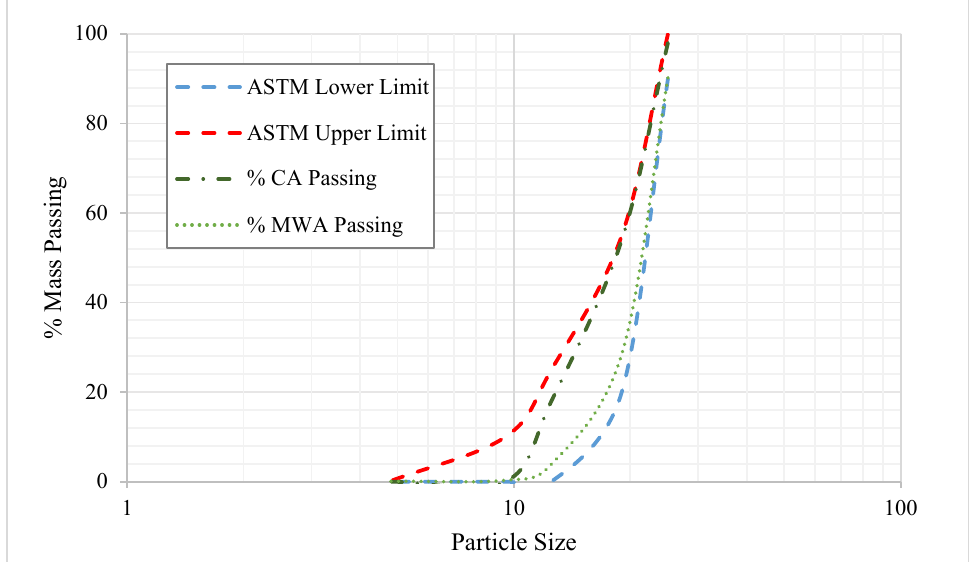
Figure 1. The particle size of MWA and standard aggregates is within the ASTM limits.